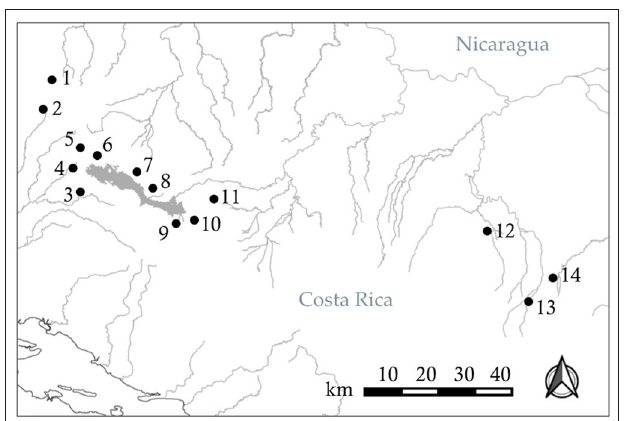
FIGURE 2 | Distribution of 14 populations of Xenophallus across their range in northern Costa Rica, sampled or monitored from 1998 to 2019. See Table 1 for details.